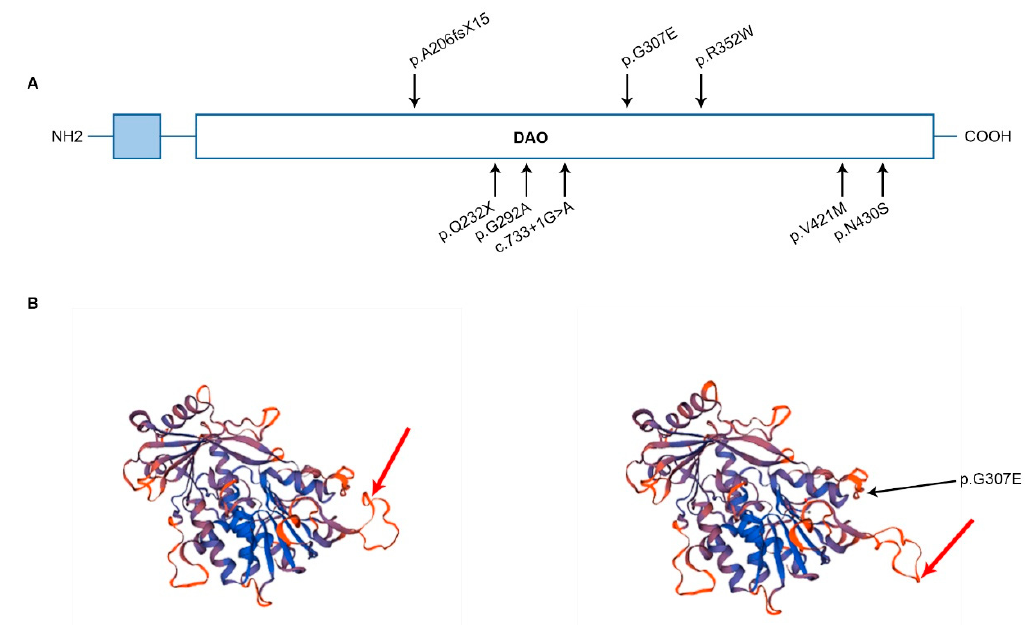
Figure 2. ( A ) Domain structure of FOXRED1 with all the variants identified in the described cases. In light blue, the cleavable mitochondrial targeting sequence is shown or displayed. DAO—FAD-dependent oxidoreductase. ( B ) FOXRED1 protein modeling wild-type and FOXRED1 protein modeling with the mutation p.G307E, reflecting the predicted consequences in the spatial protein structure due to the change of the non-polar amino acid Glycine to the negatively charged Glutamic acid.